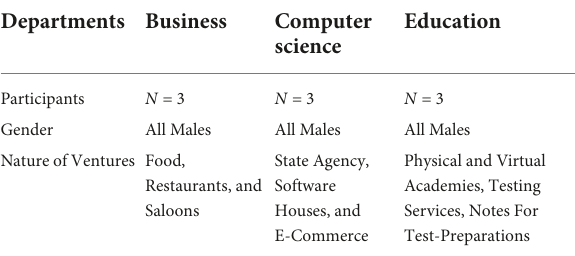
TABLE 1 Participant selection